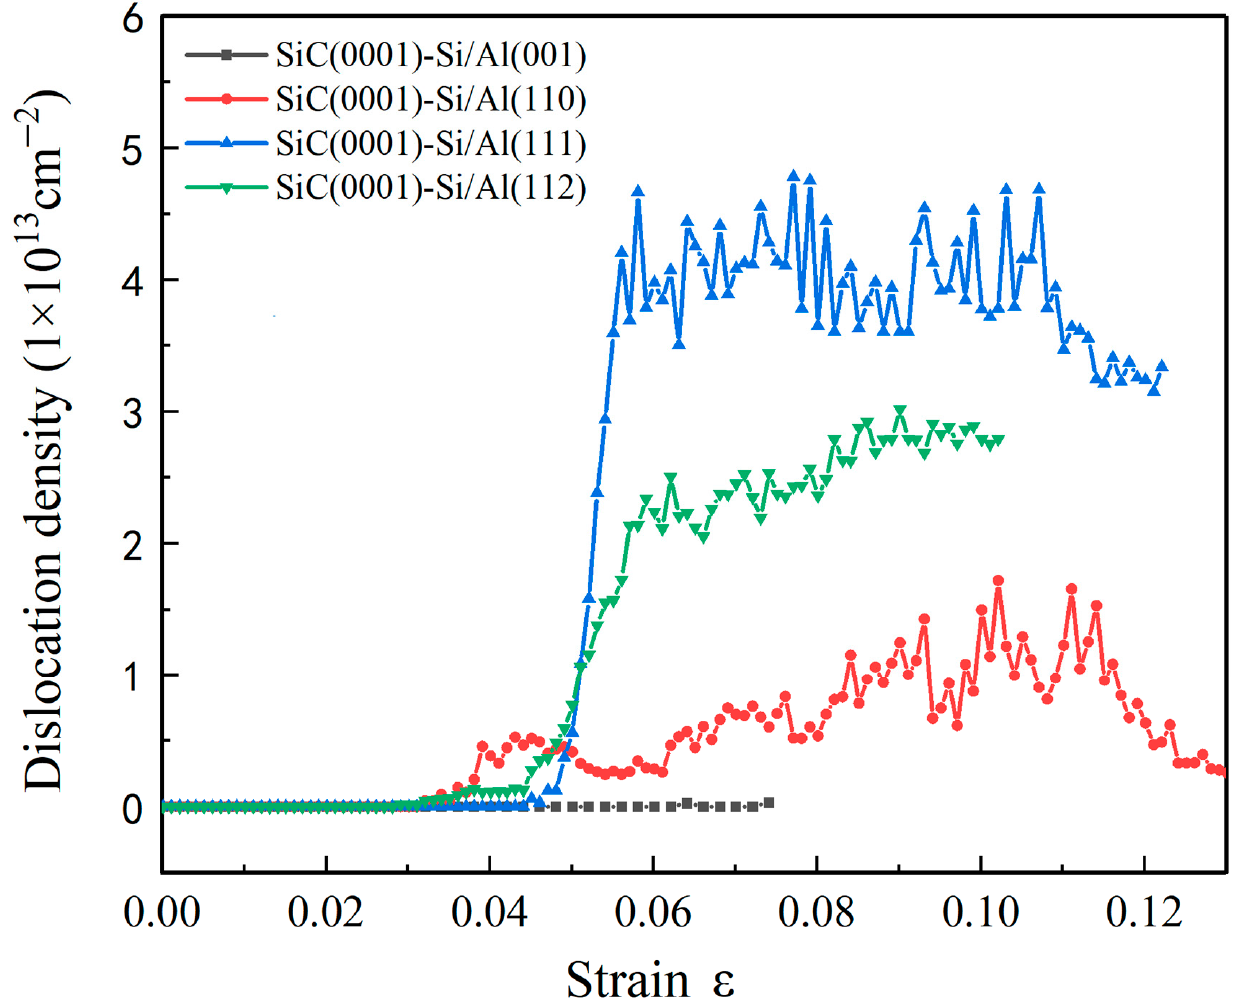
Figure 6. Dislocation density of the four SiC(0001)-Si/Al models during the tensile process.